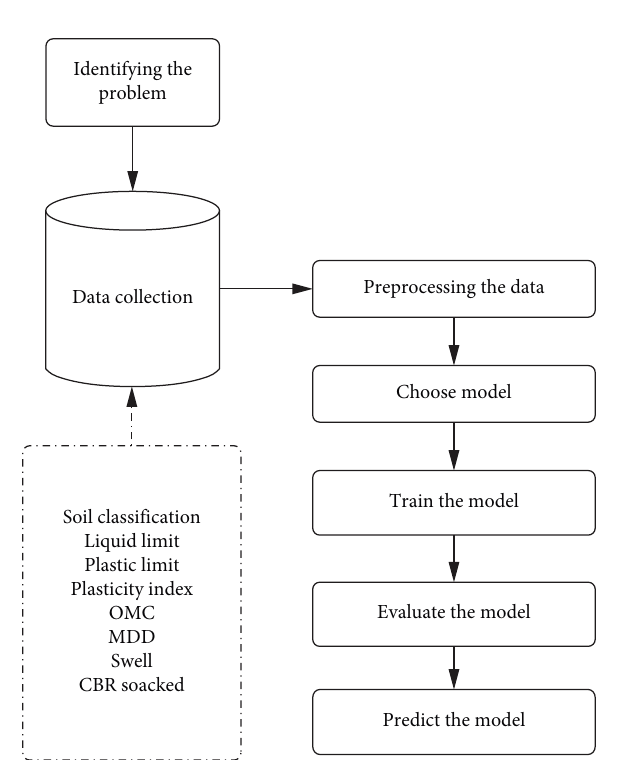
Figure 4: Proportion of CBR in the dataset.